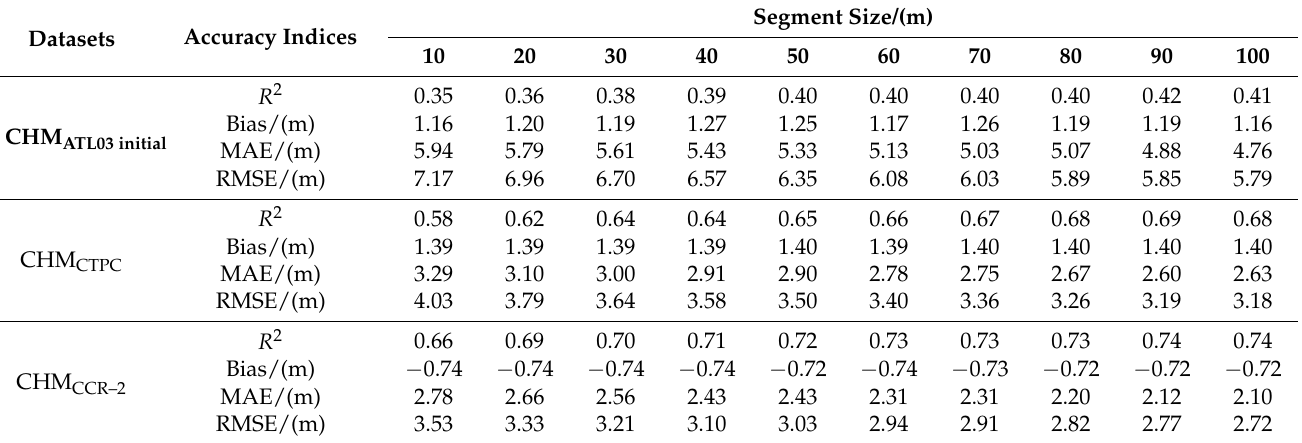
Table 4. Inversion accuracy of uncorrected and corrected canopy heights for different segment sizes.